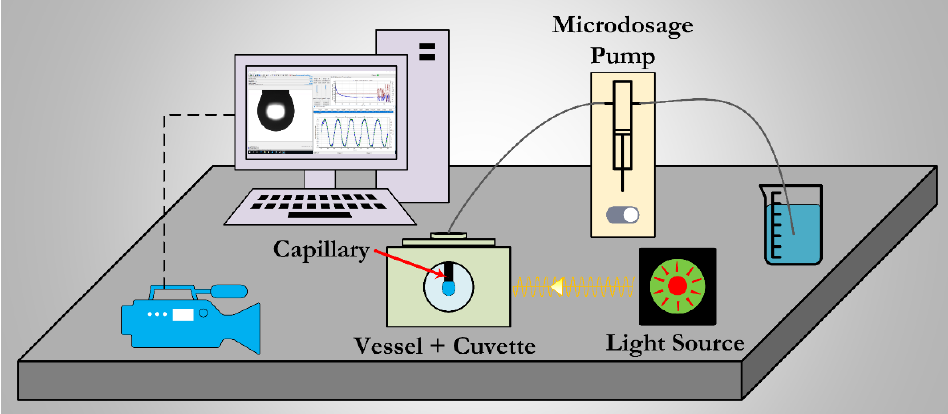
Figure 1. Schematic representation of a profile analysis tensiometer (reproduced with permission from [24], Copyright 2020 American Chemical